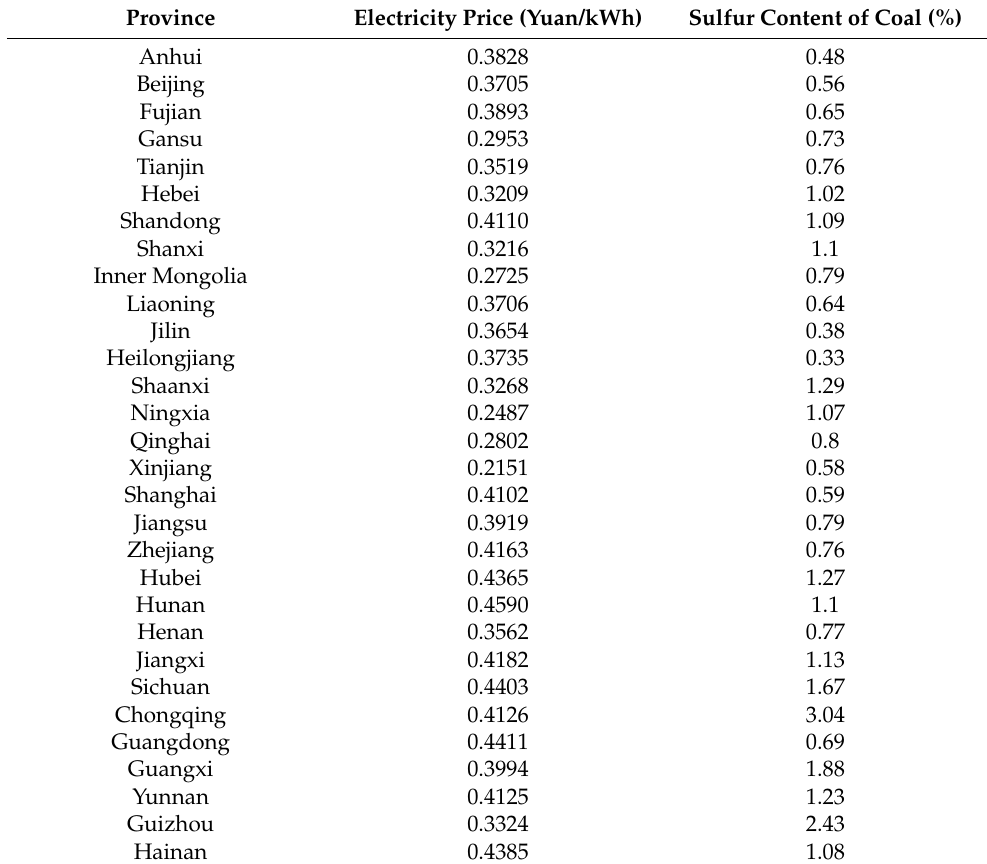
Table A1. Electricity price and sulfur content of coal of each province in 2018.